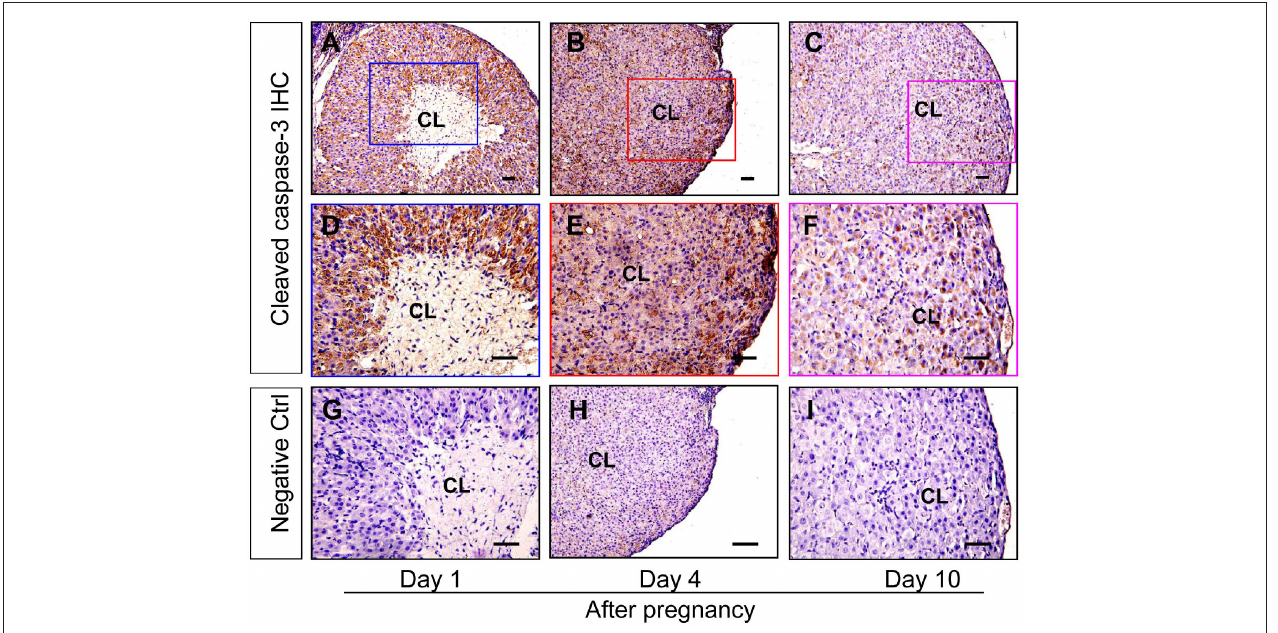
FIGURE 4 | Immunohistochemical staining of cleaved caspase-3 during the development of corpus luteum. Three time points (Day 1, 4, and 10 after pregnancy) were selected and represented as the developmental process of corpus luteum according to our previous reports. Ovarian sections of each point ( A,D,G for Day 1; B,E , and H for Day 4; C,F,I for Day 10) were immunostained for cleaved caspase-3 and counterstained with hematoxylin. The cleaved caspase-3 immunohistochemical signals appear brown, and the background counterstaining appears blue (A–F) . Negative control remained unstained, lacking primary antibody instead of serum (G–I) . CL, corpus luteum, bar = 100 µ